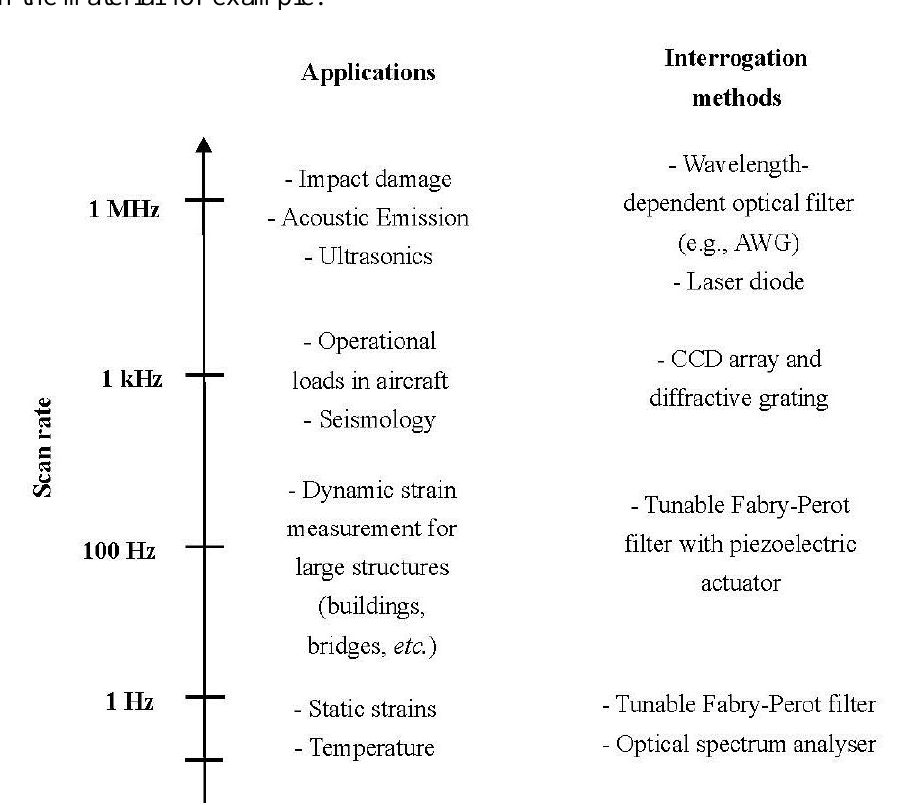
Figure 4. Schematic classification of FBG interrogation techniques based on scan rate and applications (adapted from